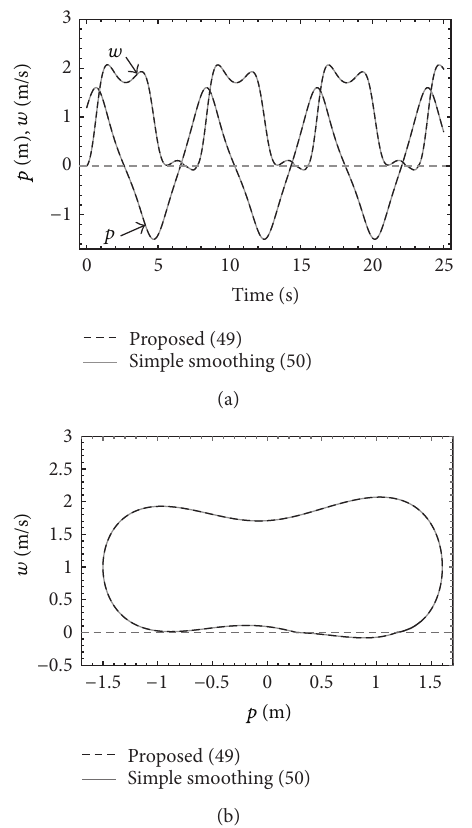
Figure 11: Simulation results of Example III by using (49) and (50) integrated by RK4 with timestep size 0.001s. The parameters in (49) are chosen as 𝐾 = 1 × 10 5 N/m and 𝛽 = 0.5 s. The parameter in (50) is chosen as 𝜖 = 10 −5